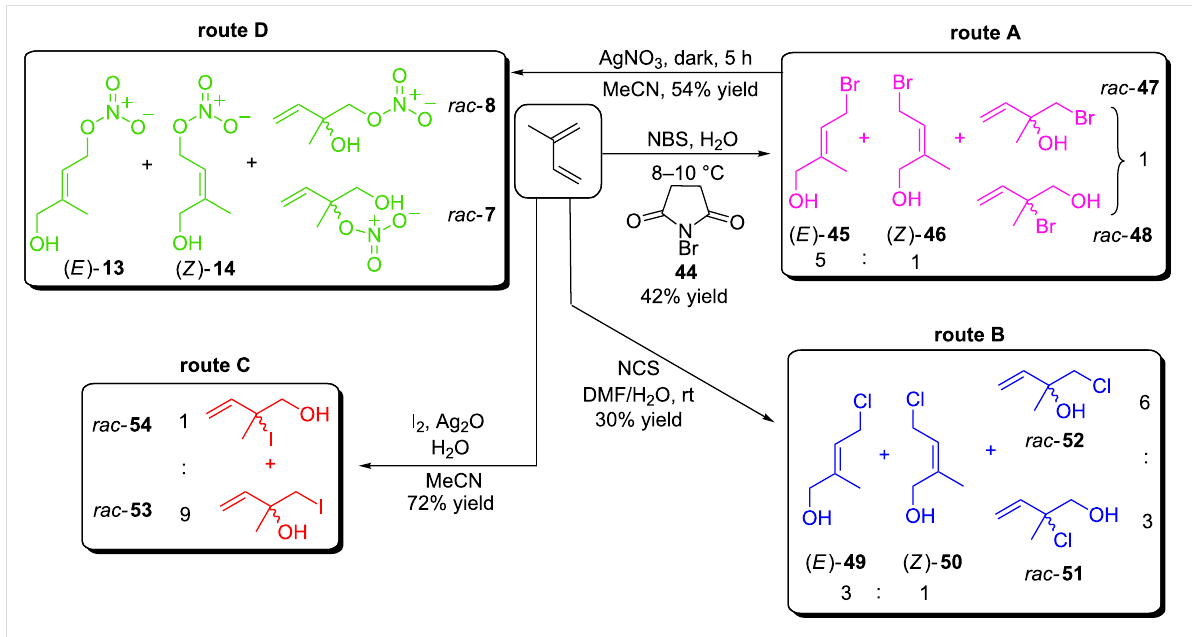
Scheme 7: Application of isoprene for the synthesis of precursors to IPNs and synthesis via ‘halide for nitrate exchange’ of rac - 7 , rac - 8 , ( E )- 13 and ( Z )- 14 .